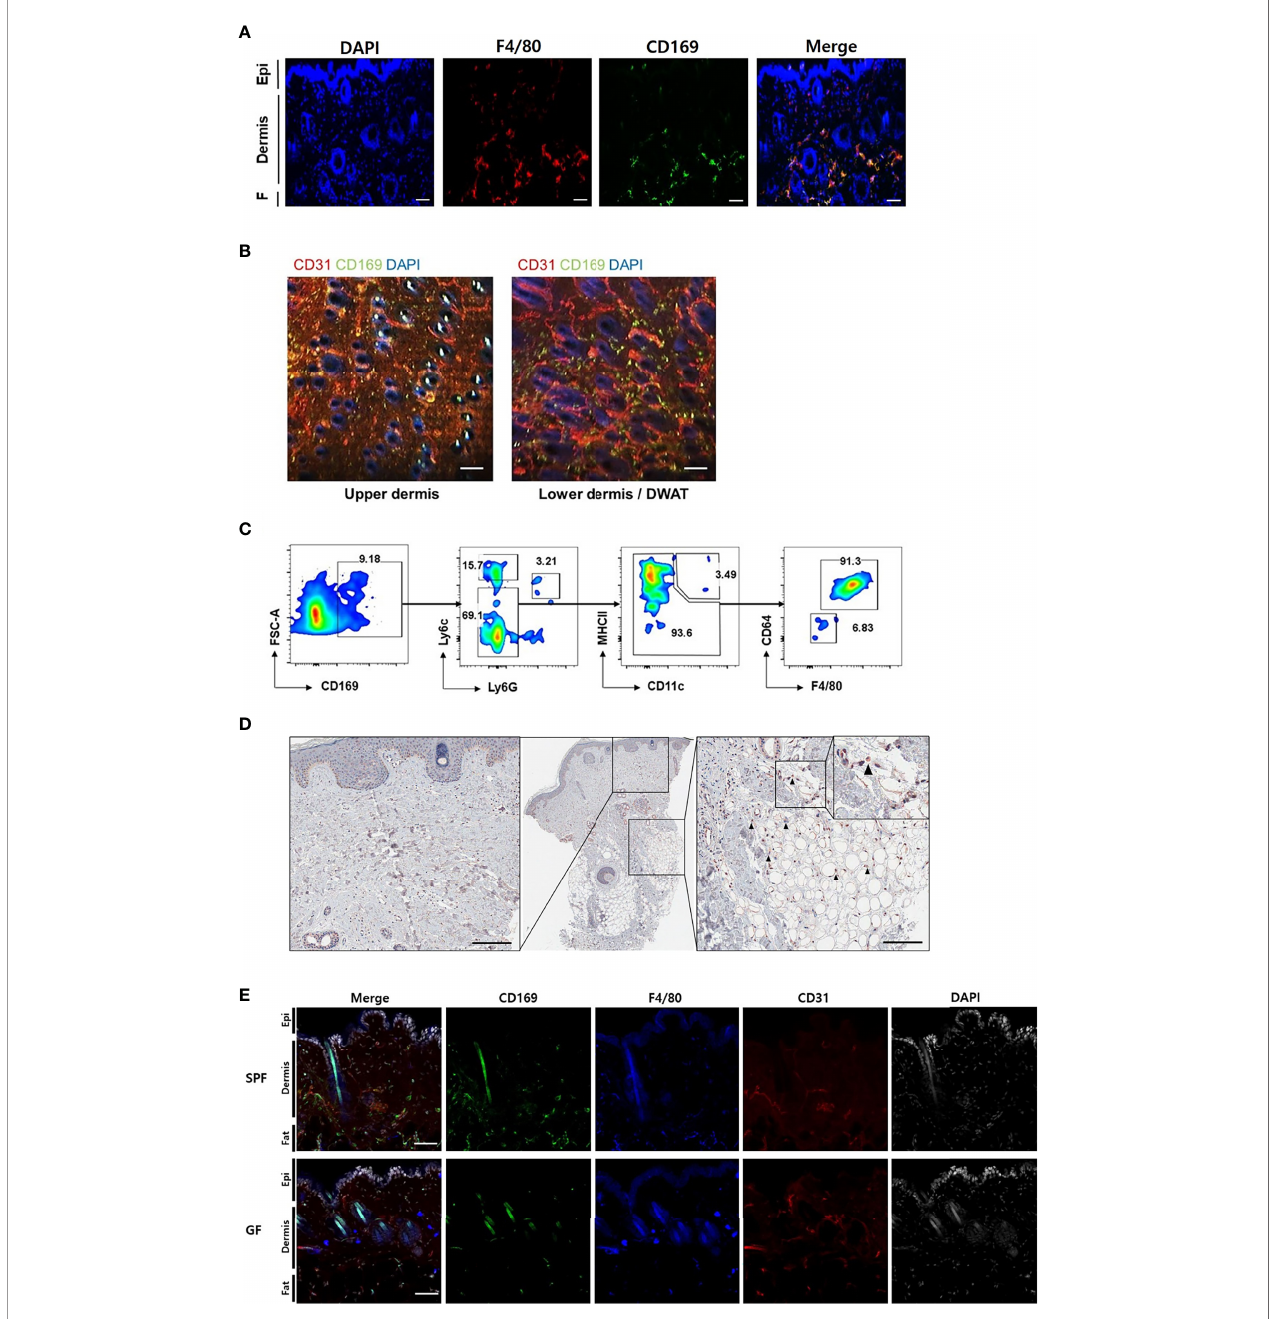
FIGURE 2 | CD169+ cells are detectable in the skin of mouse and human, and less frequent in skin of germ-free mice compared to speci fi c-pathogen-free mice. (A) Orthogonal projected image of a vertical skin section (100 µm) using confocal microscopy (F4/80-red, CD169-green, DAPI-blue color). Scale bar indicates 100 m m (Epi: epidermis, F: subcutaneous fat). (B) Merged images from a horizontal section (CD31-red, CD169-green, DAPI-blue color) of dermis and dermal white adipose tissue (DWAT) from WT mice. White spots indicate auto fl uorescent hair shafts. Scale bar, 100 m m. Images represent three (A) and two (B) independent experiments. (C) Representative gating strategy and features of FACS-sorted CD169 + cells in skin. Gated on FSC/SSC, PI - , CD45.2 and CD11b. Plots represent two independent experiments. (D) Representative human skin sample immunostained with CD169 (black arrows indicate CD169 + cells). (E) Orthogonal projected images of vertical skin sections (100 µm) from SPF and GF mice (CD169-green, F4/80-blue, CD31-red, DAPI-white color). Scale bar indicates 100 m m. Images represent three independent